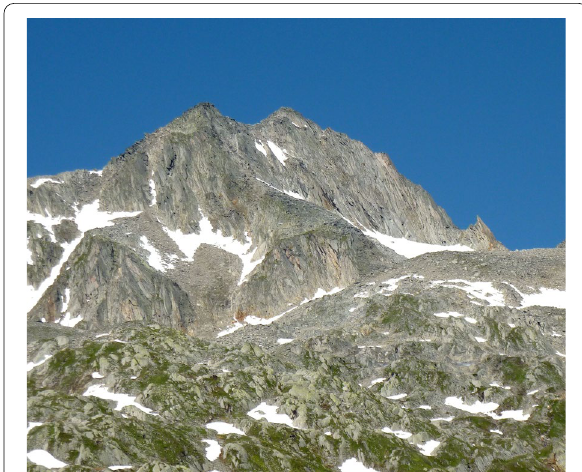
Fig. 14 Streifen-gneiss mountains of the Gotthard-Massif (Piz Rondadura 3016 m). Inferred recharge area of water collected at tunnel level (500 m). Tunnel axis crosses beneath outcrops in the foreground at 2500 m (2000 m elevation